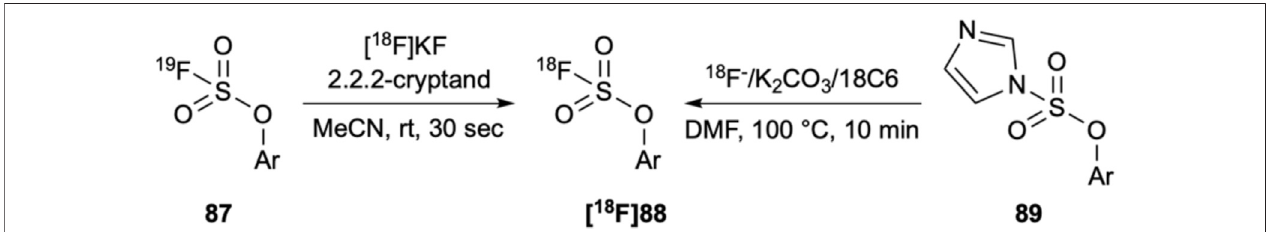
FIGURE 14 | (A) Aryl [ 18 F] fl uorosulfates have been synthesized via 19 F/ 18 F isotopic exchange at room temperature in only 30 s and (B) The same target can be made from the corresponding imidazylates at 100 ° C in 10 min. Neither have been tested in aqueous conditions.